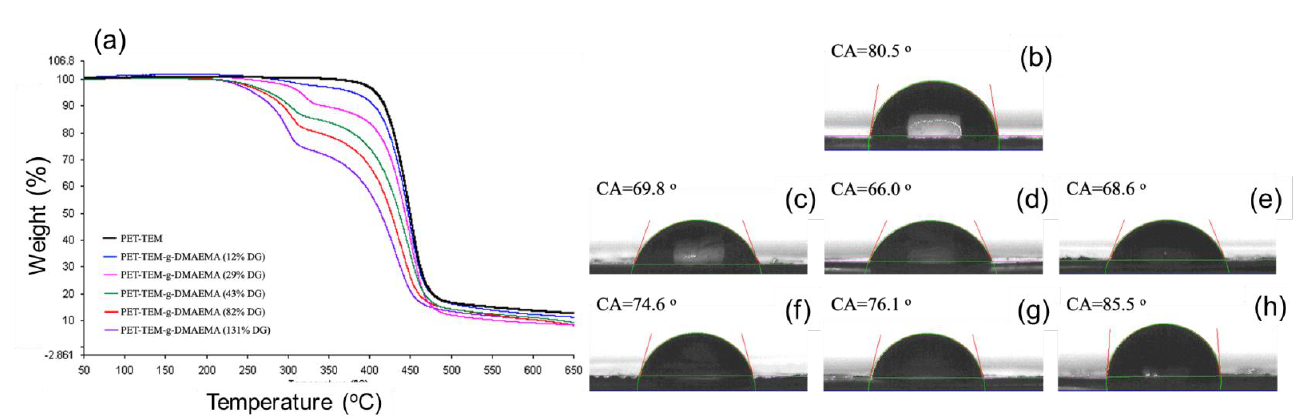
Figure 5. Thermogravimetric curves for pristine and PDMAEMA grafted PET TeMs heated in a 50 – 650 °C range ( a ) . Contact angle (CA) measurements of oxidized PET TeM ( b ) and PDMAEMA grafted TeMs with different DGs; 12% DG ( c ), 22% DG ( d ), 29% DG ( e ), 35% DG ( f ), and 43% DG ( g ), and 66% DG ( h